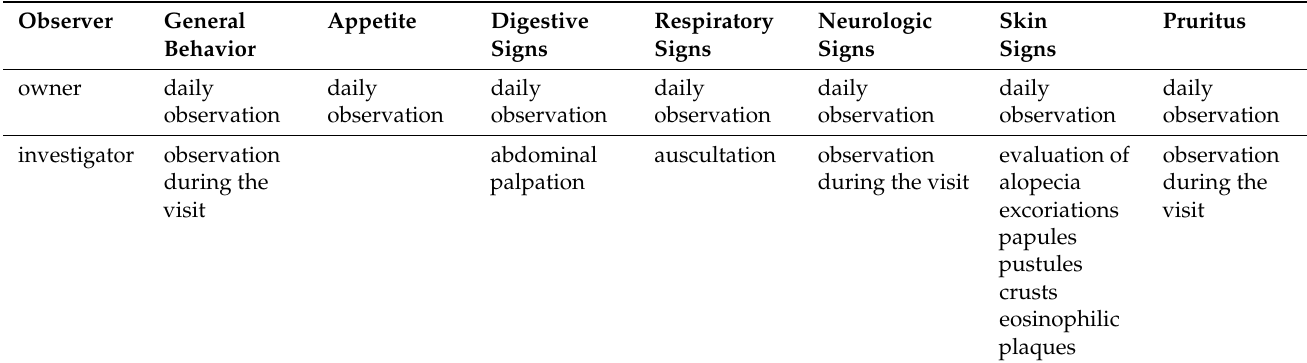
Table 2. Overview of the different parameters assessed on the animals during this